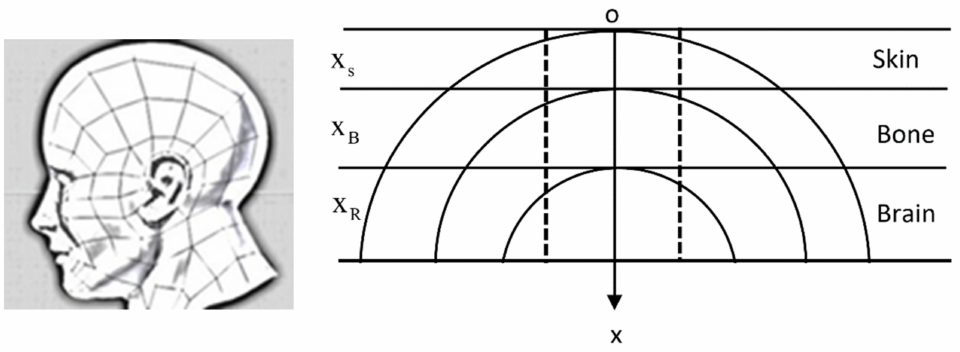
Figure 1. The human head